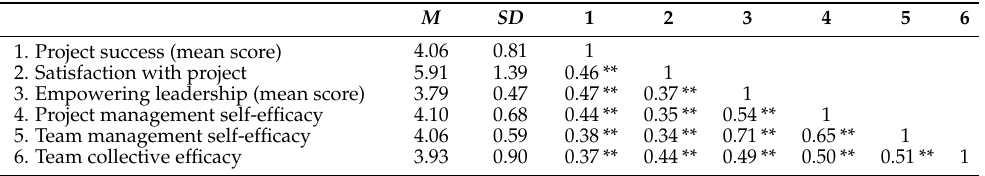
Table 3. Correlation matrix for all measured variables (Spearman correlation